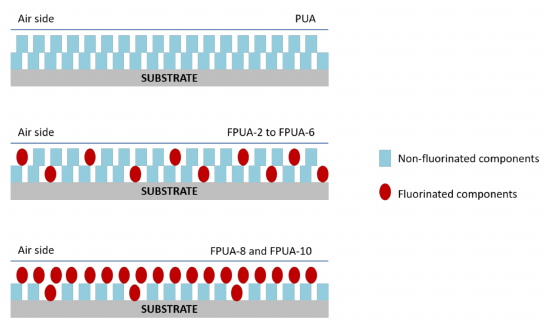
Figure 7. Schematic illustration of the enrichment and reconfiguration of fluorinated monomer that cause variation in surface